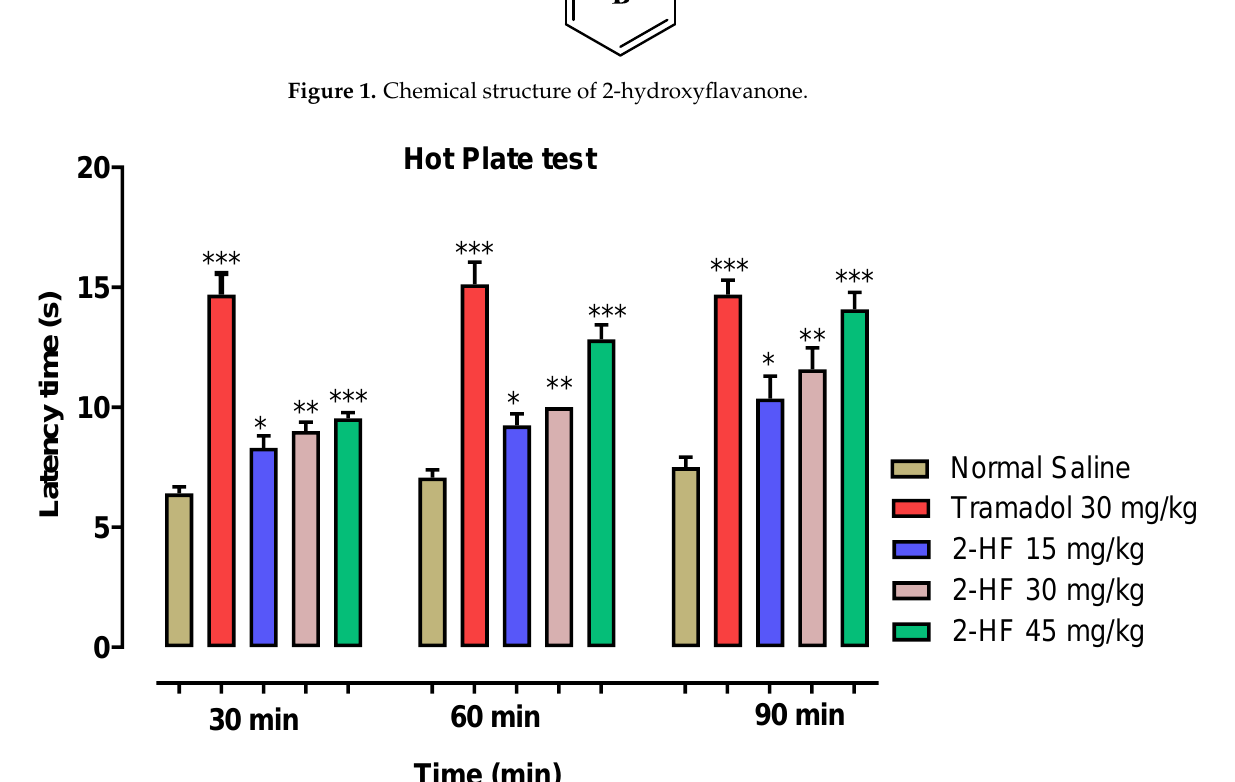
Figure 2. Results of hotplate study performed on 2-HF. *** p < 0.001, ** p < 0.01, * p < 0.05 when compared with control, two-way repeated measures ANOVA followed by Tukey’s post hoc test.